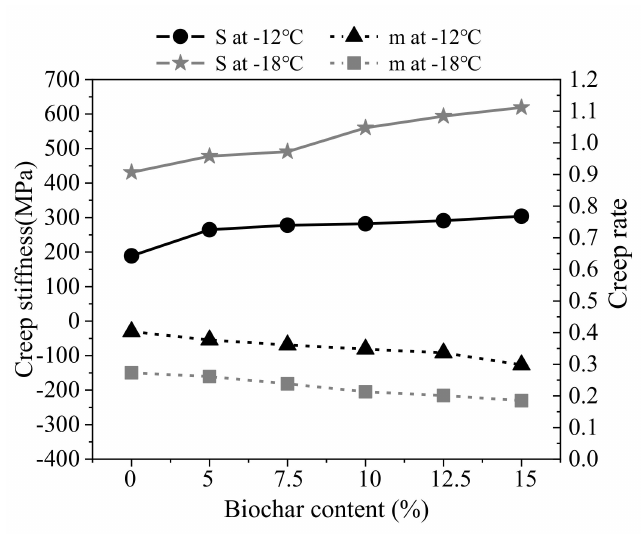
Figure 10. BBR results of biochar modified asphalt binder after long-term